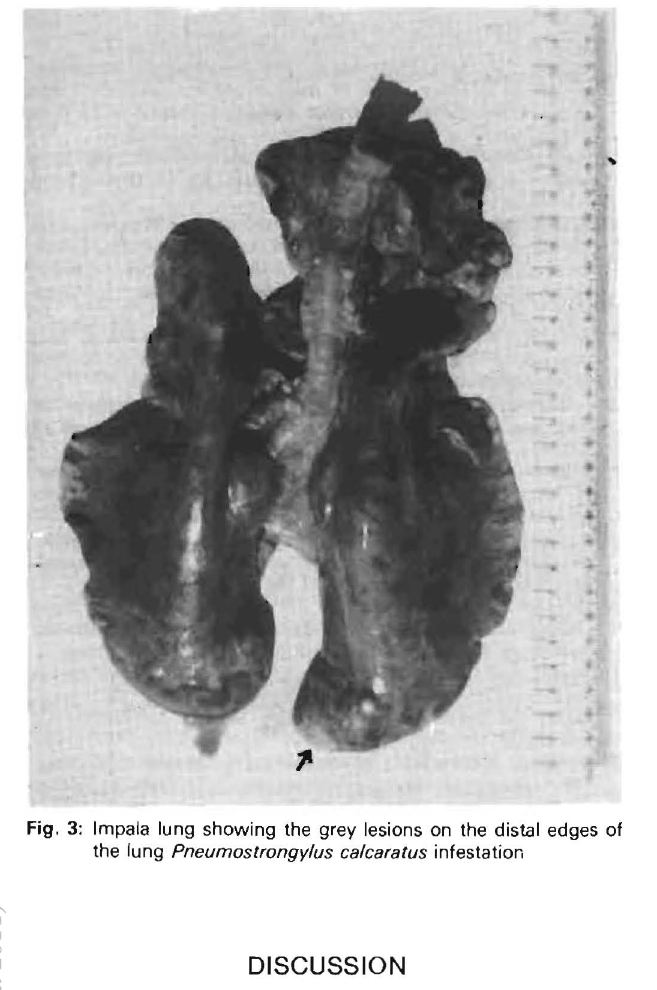
Fig. 3: Impala lung showing the grey lesions on the distal edges of the lung Pneumostrongv1us calcaratus infestation